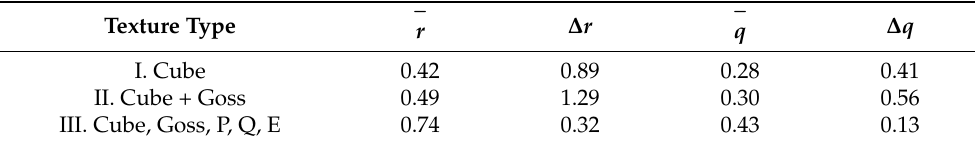
Table 2. Quantitative indicators of plastic yielding in various texture types shown in Figure